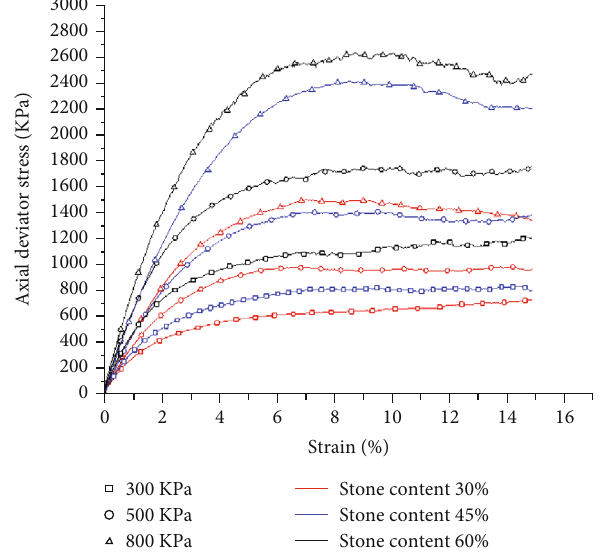
Figure 12: Stress-strain curve of gravel soil mixture with di ff erent stone